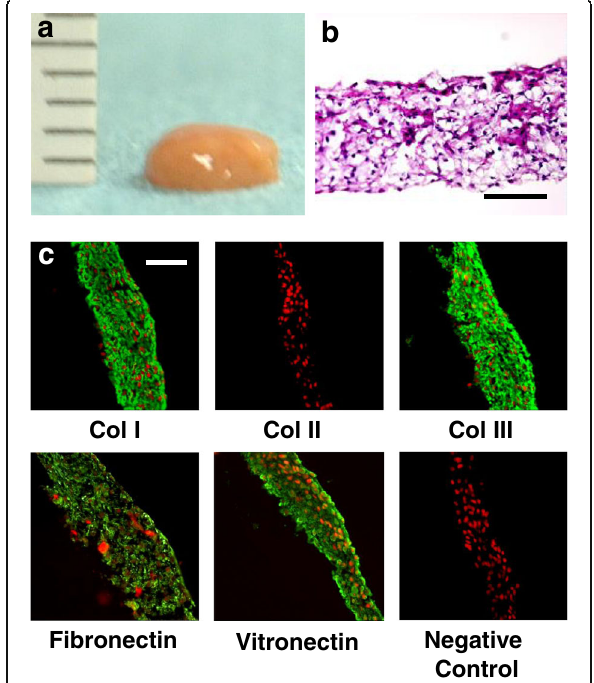
Fig. 1 Development of the tissue-engineered construct (TEC). a Macroscopic view of the TEC that was integrated to one spherical body. b Hematoxylin and eosin staining of TEC. c Immunohisto- chemical analysis of the TEC stained with type I collagen (Col I), type II collagen (Col II), type III collagen (Col III), fibronectin, vitronectin, and negative IgG (control). Red are nuclei and green is target anti- body. Adhesion molecules such as fibronectin and vitronectin are diffusely distributed within the TEC. Bar = 100 μ m. Quoted and modi- fied from Ando et al. , Biomaterials 2007 and Shimomura et al. Cartilage